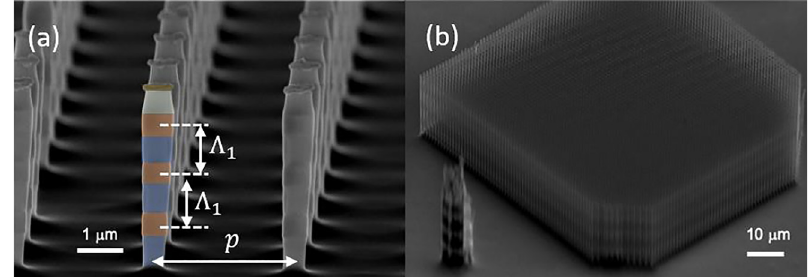
Figure 3: (a) Scanning Electron Microscope (SEM) image of three lines of a three-layer metasurface with Λ 1 = 900 nm and p = 3 μ m (b) SEM image of an entire three-layer